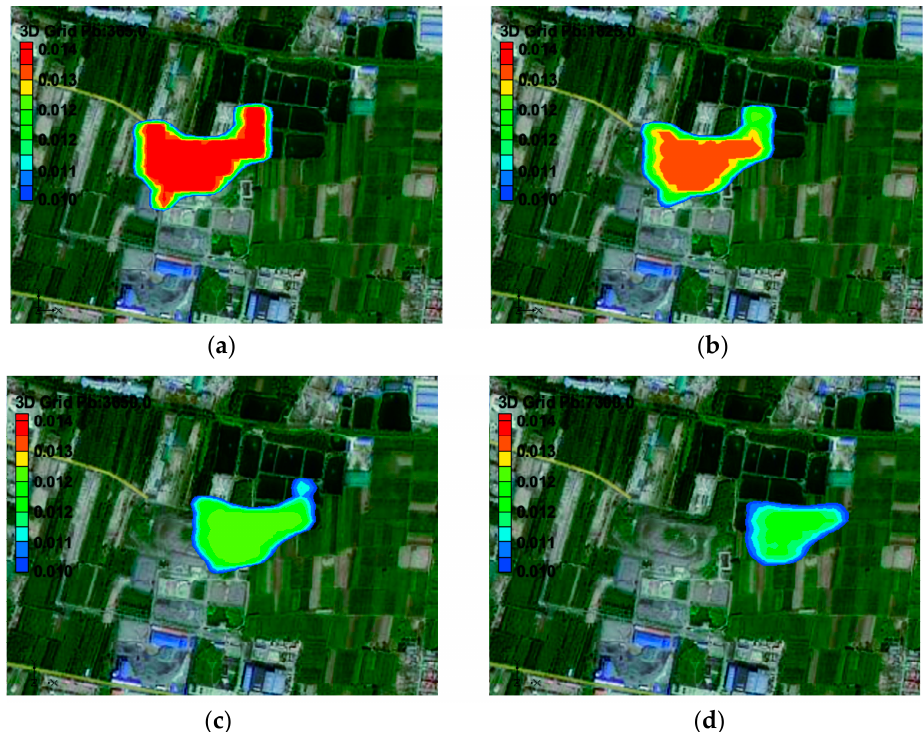
Figure 11. Pb concentration distribution map. ( a ) After 1 year; ( b ) After 5 years; ( c ) After 10 years; ( d ) After 20 years.